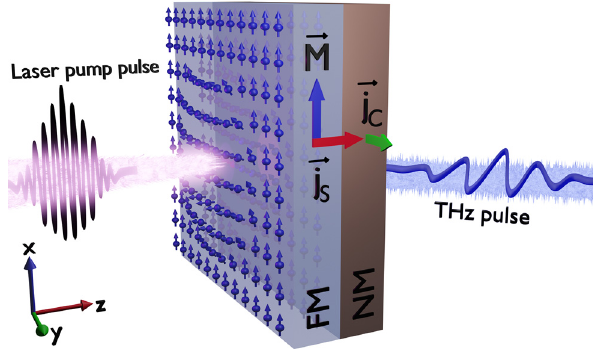
Figure 1: Graphical representation of the THz emission from FM/NM heterostructures after fs-laser excitation of the spin system. The magnetization points in positive x -direction, j s is the spin current in z -direction, along the layer stacking and j c is the charge current in y -direction. The inverse spin Hall effect leads to the THz radiation. The polarization of the THz fi eld is perpendicular to the direction of the magnetic fi